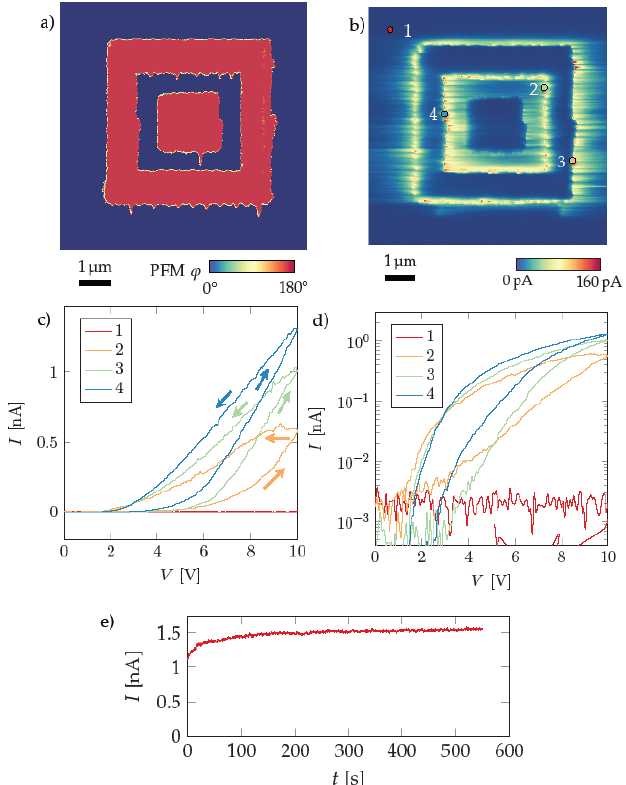
Figure 1. DW conductance in the congruent LNO thin films: ( a ) domain configuration by PFM; ( b ) cAFM scan at a bias voltage of 3 V; ( c ) Local I–V measurements on conductive DWs at four marked spots; ( d ) logarithmic plot of the detected current; ( e ) temporal development of the current at spot 4 at an external bias voltage of 10 V.